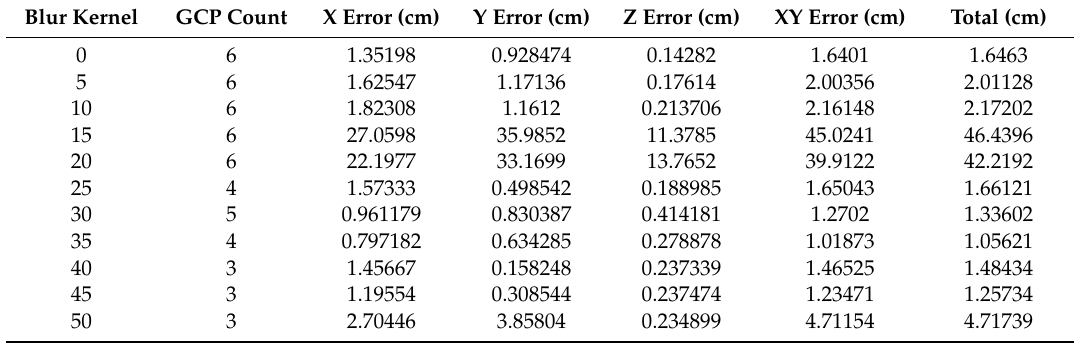
Table 4. Control points root mean square error (RMSE). X—Easting. Y—Northing.